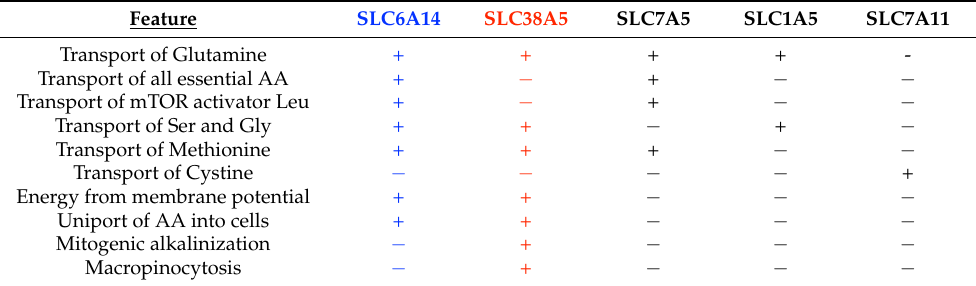
Table 1. Functional features of SLC6A14 and SLC38A5 that distinguish these two transporters from other amino acid transporters known to be upregulated in